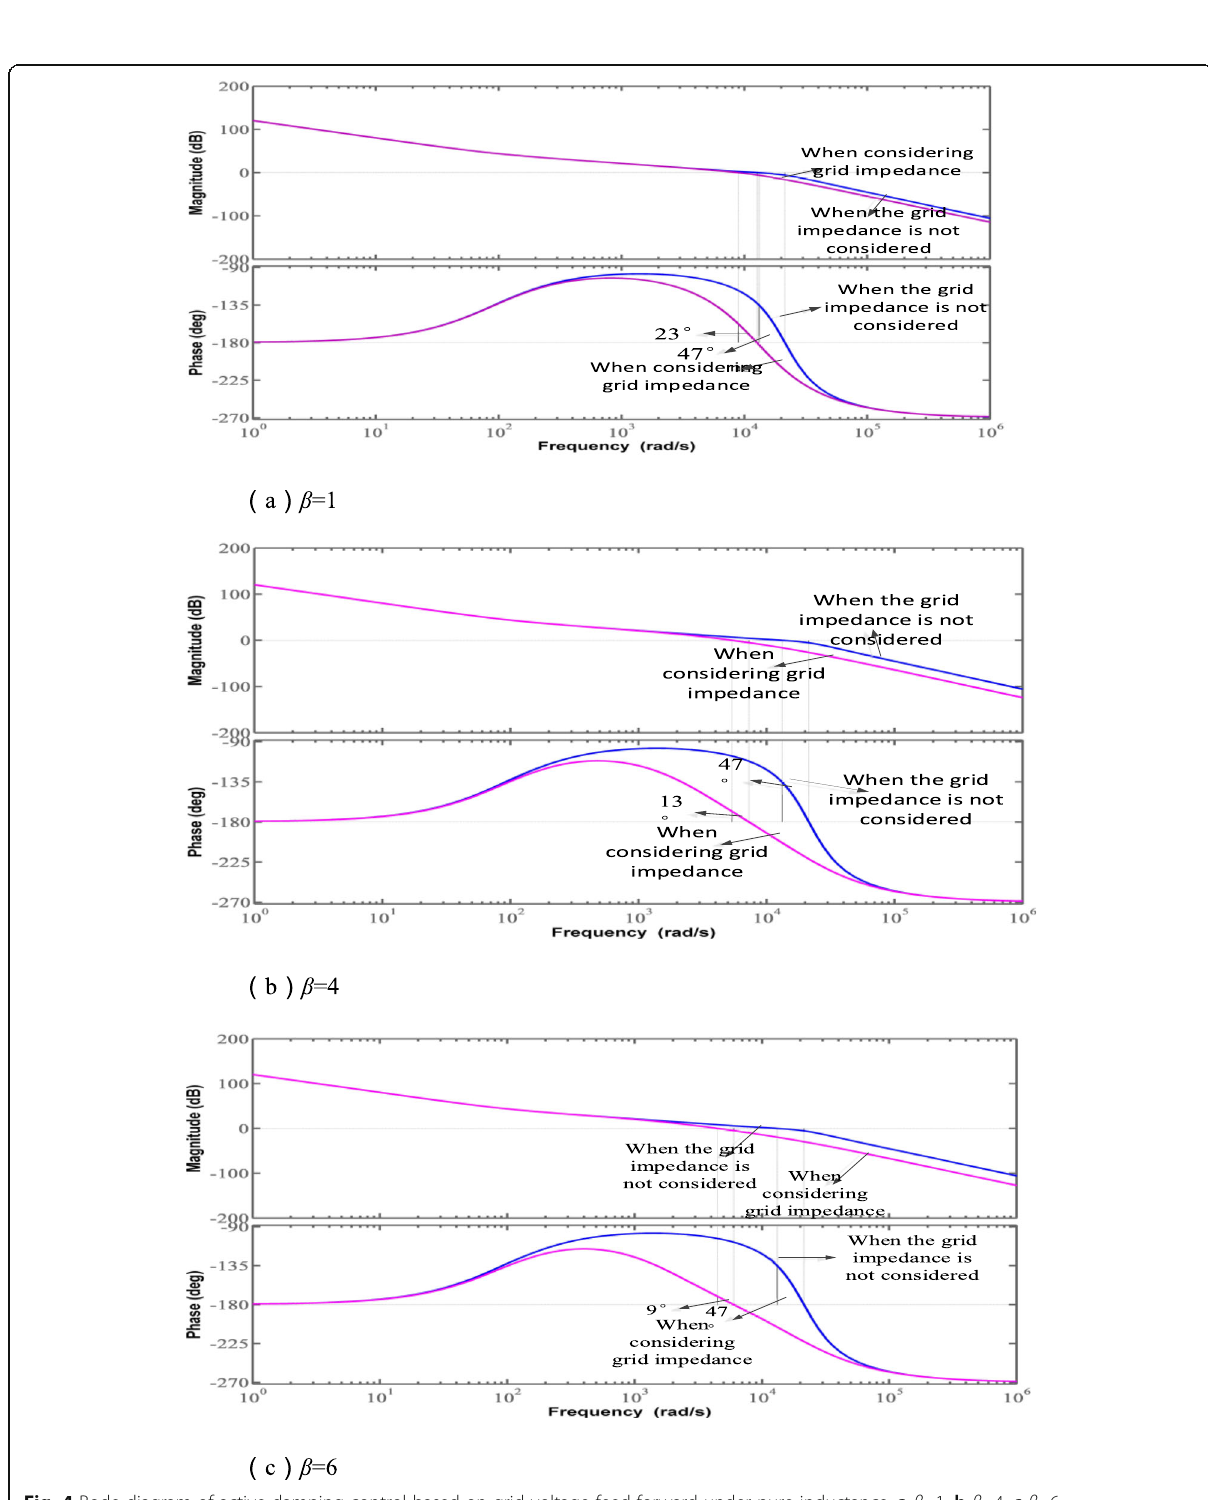
Fig. 4 Bode diagram of active damping control based on grid voltage feed-forward under pure inductance. a β =1. b β =4. c β